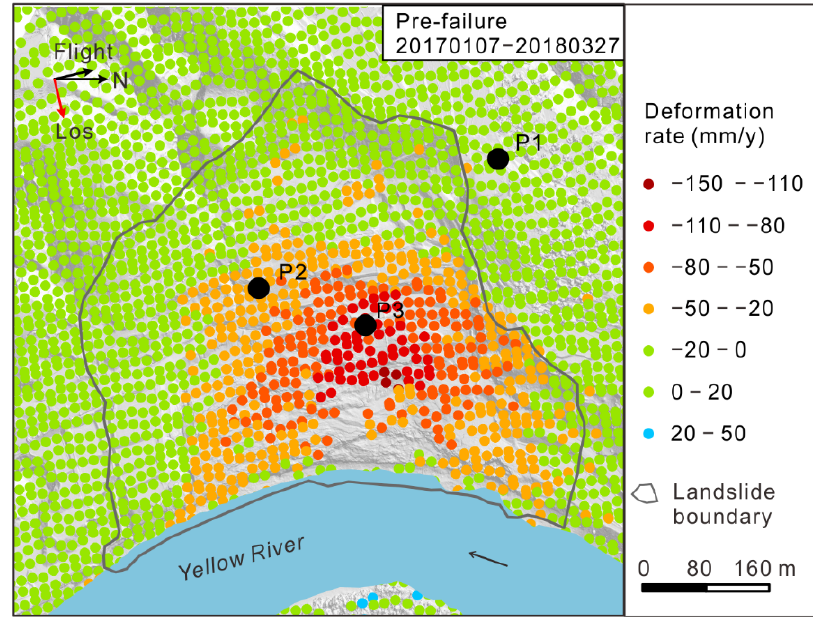
Figure 6. Pre-failure mean LOS deformation velocity. To further research the spatial deformation of the landslide, we studied the pre-failure cumulative LOS displacement (Figure 7). The lower part became unstable the earliest, which is mainly attributed to the river eroding away the weak structural plane at the bottom of the slope (Figure 3a). Then, because the original balance of the structure of the lower part was destroyed, the upper part lost its support, and the deformation area gradually extended into the upper and surrounding areas. By 27 March 2018, the maximum cumulative LOS displacement deformation reached − 135 mm, and the evolution exhibited a typical retrogressive failure